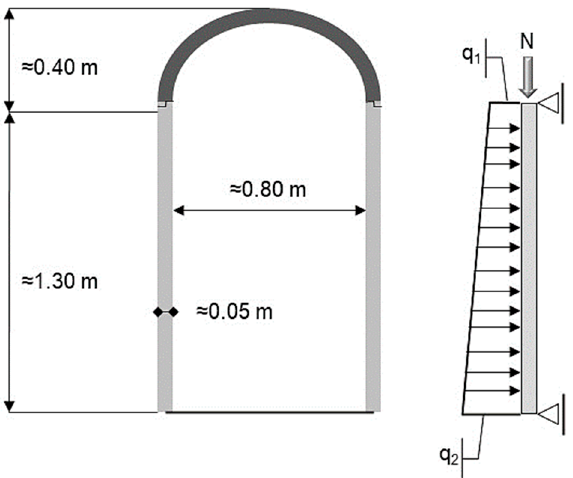
Figure 4. Tunnel wall beam model.